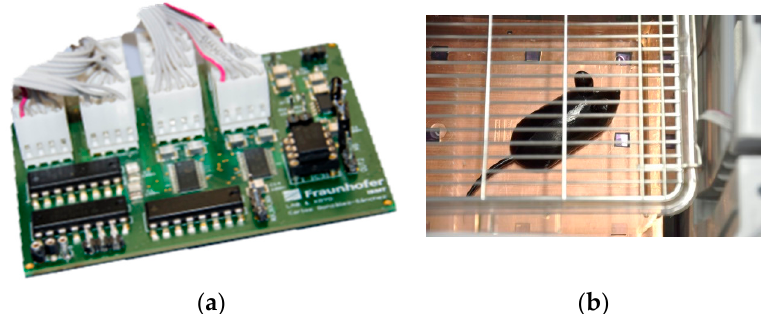
Figure 3. ( a ) Self ‐ designed printed circuit board (PCB) used to control the 4 × 4 matrix of electric potential integrated circuit (EPIC) sensors. ( b ) Matrix of EPIC sensors used for physiological signals capturing in rodents.